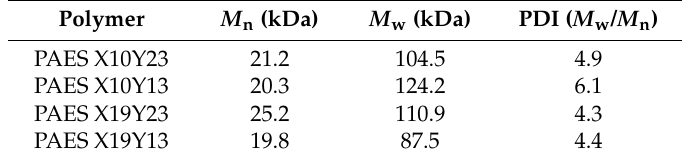
Table 2. Molecular weights ( M n and M w ) and PDI ( M w / M n ) of PAES block co-polymers.